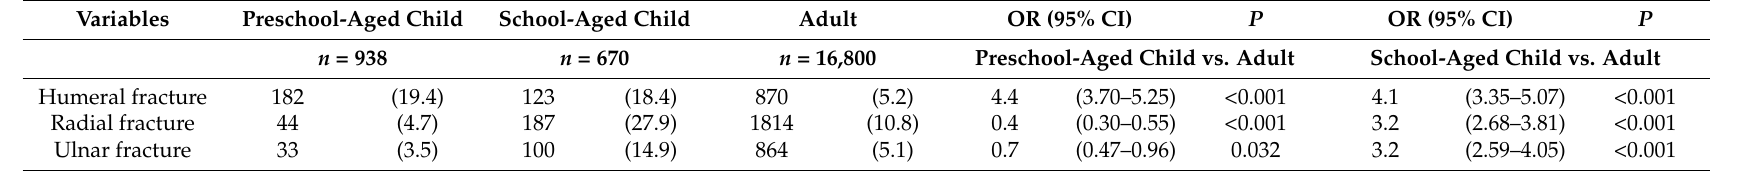
Table 3. Associated injuries with higher odds of incidence among preschool-aged and school-aged children than in adults.